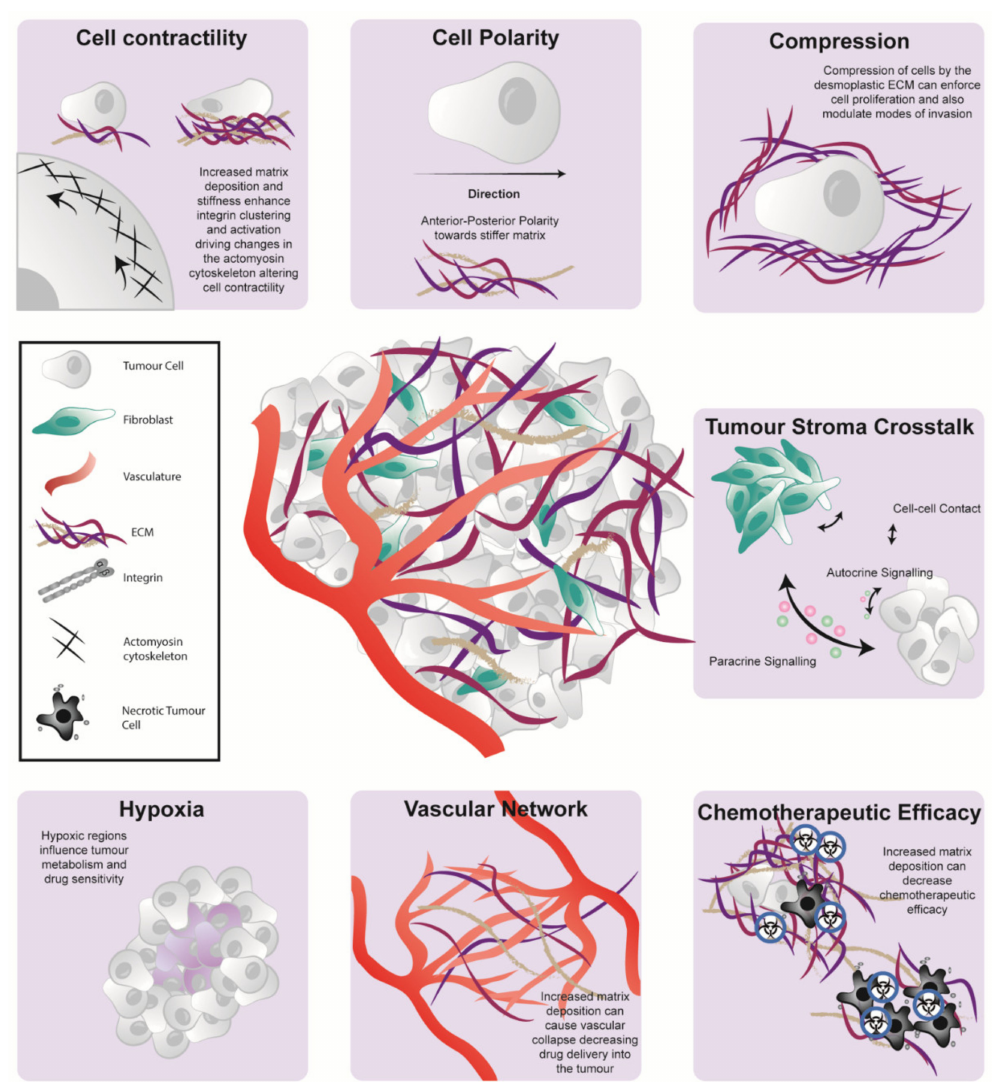
Figure 4. The pancreatic microenvironment influences tumorigenesis via a range of biochemical and biomechanical phenomena. The pancreatic TME has multiple influences on cell be havior including cell contractility (top left), cell polarity (top middle), the generation of compression forces (top right) and tumor-stroma crosstalk via direct cell-cell contact, paracrine or autocrine signaling (middle right). It can also cause the generation of hypoxic tissue pockets (bottom left), modulation of the tumor vascular network (bottom middle) and diminished cancer cell vulnerability to chemotherapy (bottom